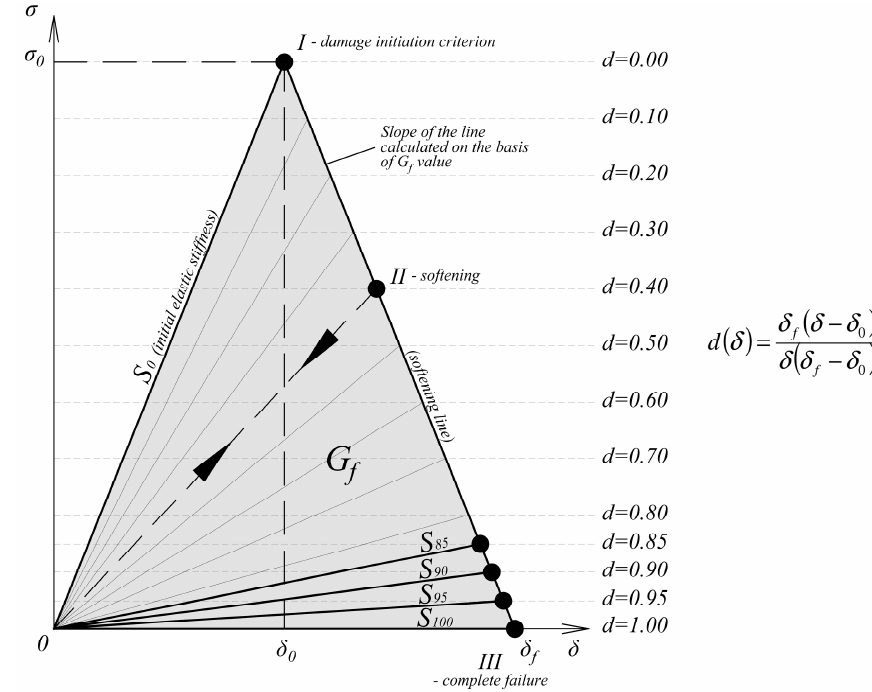
Figure 10. Damage rate parameter d —explanation.